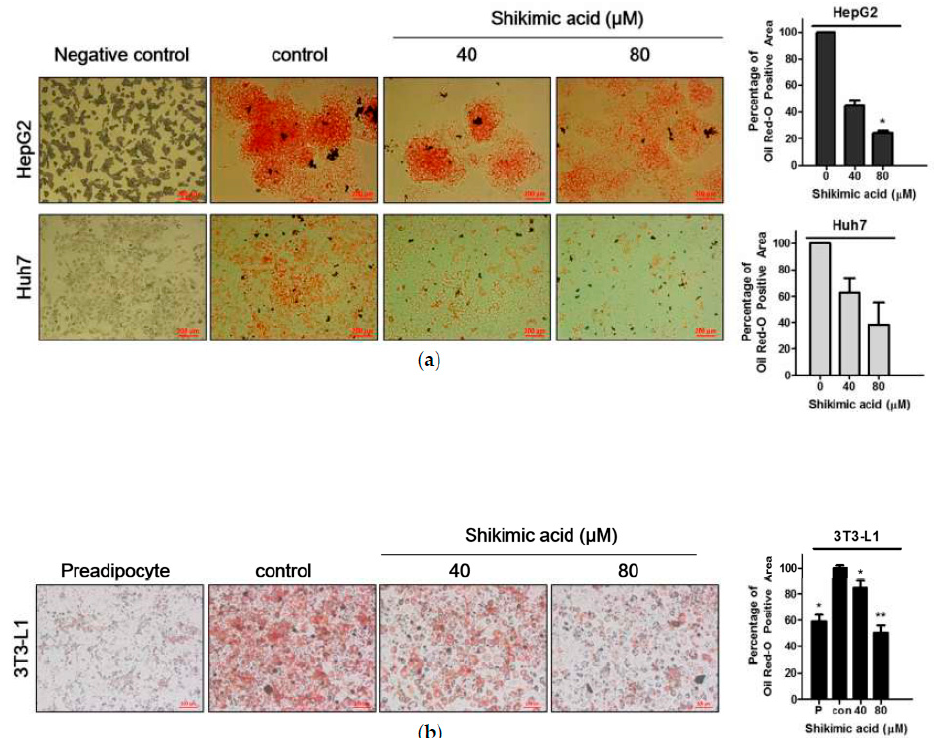
Figure 2. Effect of shikimic acid on lipid accumulation by Oil Red O staining in HepG2 and 3T3 ‐ L1 cells. ( a ) Effect of shikimic acid on lipid accumulation in HepG2 cells by Oil red staining. Scale bar = 200 μ m. ( b ) Effect of shikimic acid on lipid accumulation in 3T3 ‐ L1 cells. Shikimic acid was treated for 24 h in HCCs and 3T3 ‐ L1 cells. Scale bar = 100 μ m. P: Preadipocyte. All experiments were